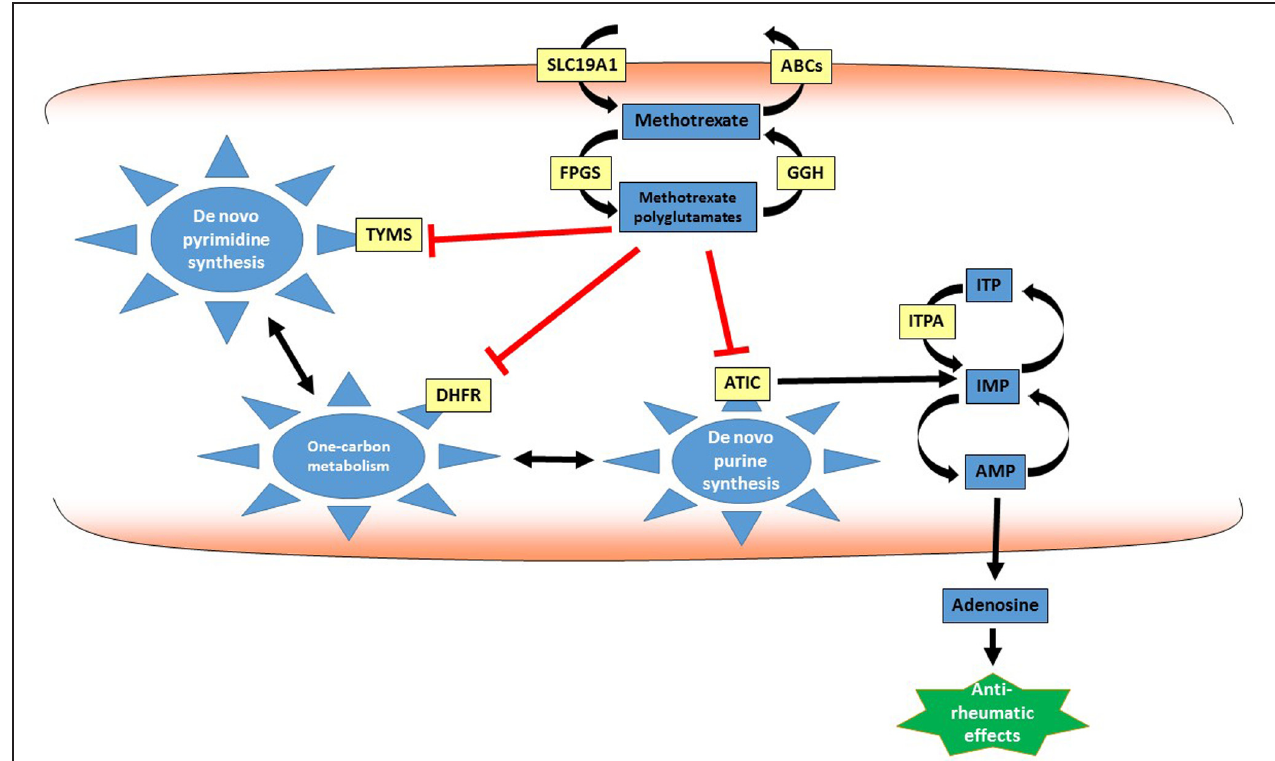
FIGURE 1 | Methotrexate pathway. Methotrexate and its active polyglutamate metabolites interfere with several intracellular metabolic processes in particular one-carbon metabolism and de novo purine and pyrimidine synthesis, by inhibiting the activity of key enzymes such as DHFR, ATIC, and TYMS. This antimetabolic effect may lead to alteration in intracellular nucleotide pools and increased adenosine release, determining the